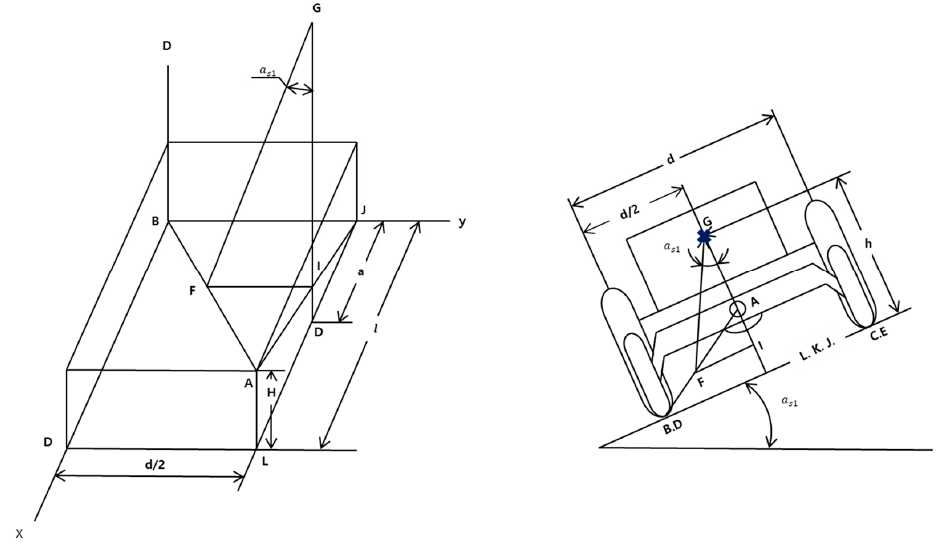
Figure 3. The determination of the lateral overturning of the radish harvester. The preliminary center of the radish harvester was G ( 𝑎, 𝑑/2, ℎ ) at the line of AB. To obtain the overturning angle for the front wheel, the position of the CoG was newly as- sumed to be G (cid:4593) (cid:4666)𝑥 (cid:2868)(cid:4593) , 𝑦 (cid:2868)(cid:4593) , 𝑧 (cid:2868)(cid:4593) (cid:4667) at the line BD. The front-wheel overturning angle ( 𝑎 (cid:3046)(cid:3033) ) was de- termined using Equation (3) [29].